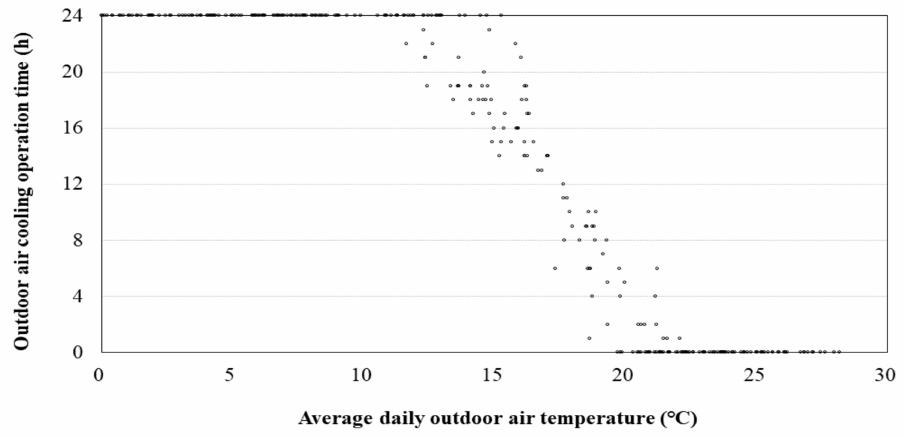
Figure 14. Outdoor air-cooling operating time according to the average outdoor air